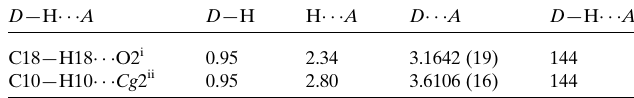
Table 1 Hydrogen-bond geometry (A˚ , (cid:2) ).